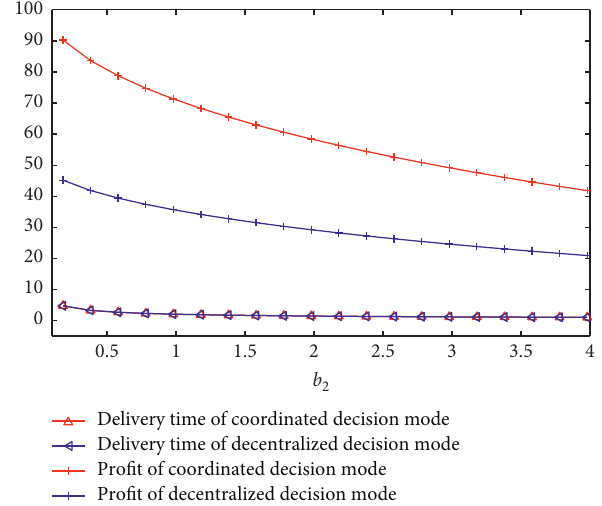
Figure 3: The delivery time and supply chain profit of the coor- dinated mode and decentralized mode supply